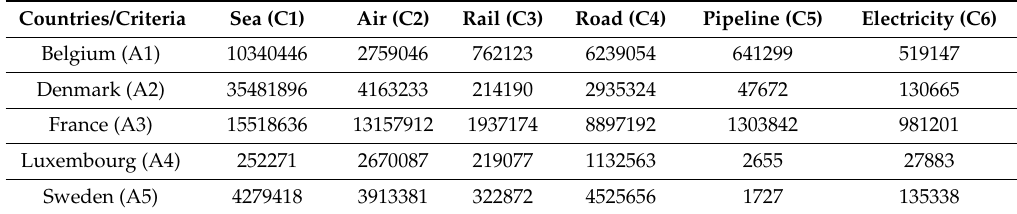
Table A4. Selected Data of Transport Export for the EU by 2013 (US Dollar, Thousand).